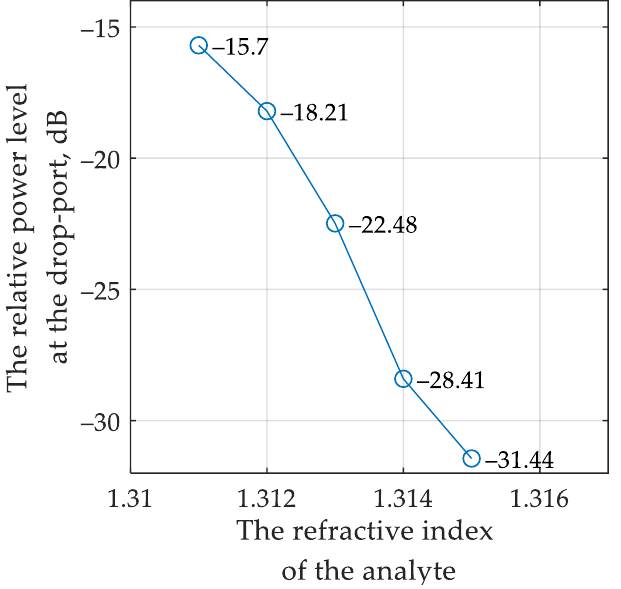
Figure 11. Modeled dependence of the relative power at the system output on the analyte RI in the scheme using an OEO as a source.